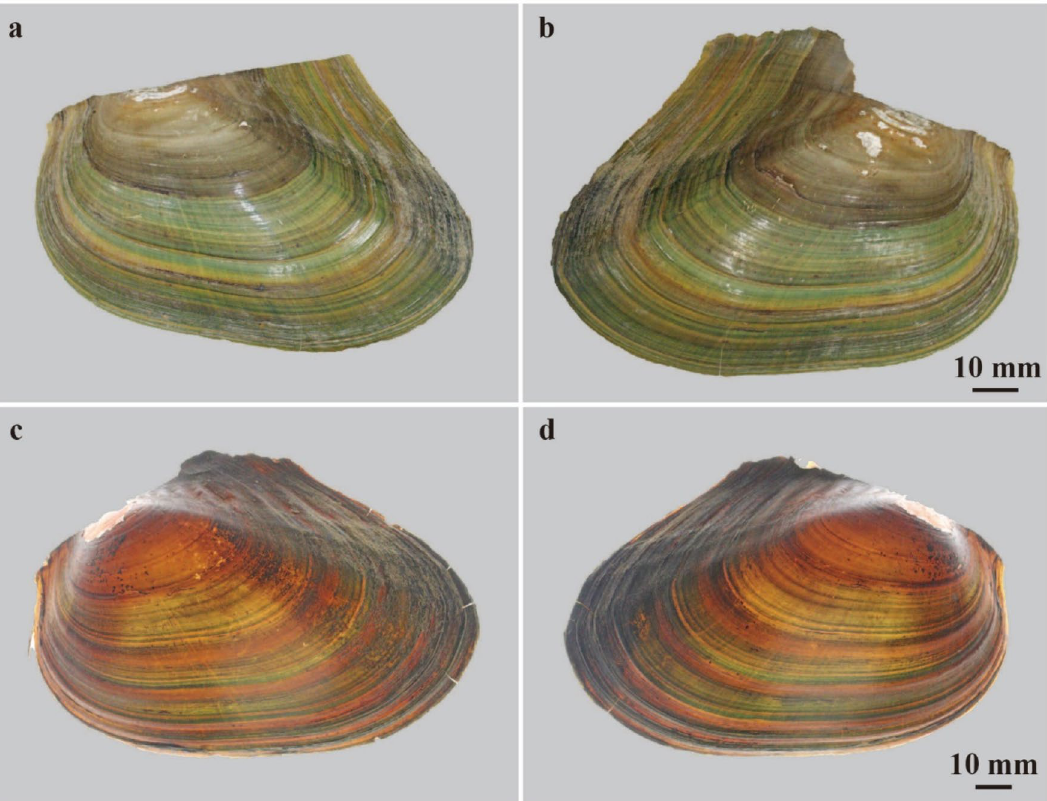
Figure 5. Color patterns of extant freshwater bivalves Cristaria plicata . ( a , b ) Juvenile individual, FPDM-I-0002911 from Lake Biwa, Shiga, Central Japan. ( a ) Left valve under normal right; ( b ) right valve under normal light. ( c,d ) adult individual, FPDM-I-0002916 from Lake Teganuma, Chiba, eastern Japan. ( c ) Left valve under transmitted light; ( d ) right valve under transmitted